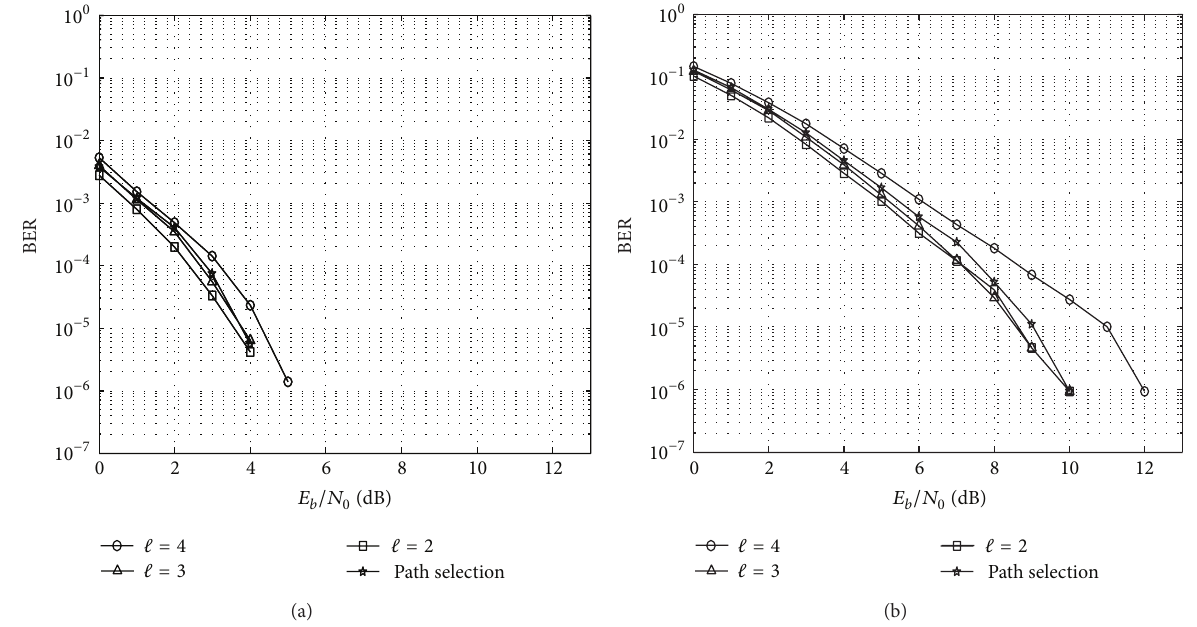
Figure 3: BER performance of 2 × 2 SFBC-OFDM system over the six-path fading channel with 13nsec delay spread for (a) 16-QAM modulation and (b) 64-QAM